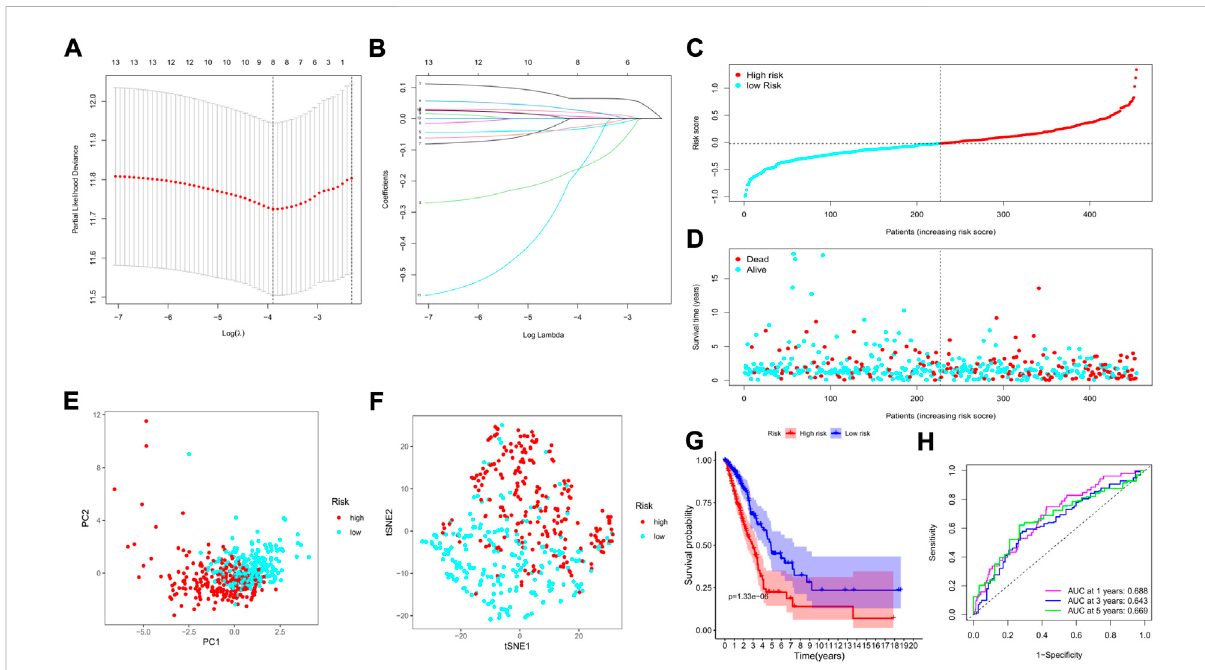
FIGURE 5 Construction of a risk model based on the TCGA cohort. (A) The cross-validation for tuning the parameter selection; (B) The LASSO regression forthe13candidategenes; (C) Thedistributionofriskscoresforthepatients; (D) Survivalstatusforeachpatient(low-risk:leftofthedottedline;high- risk:rightofthedottedline); (E) ThePCAplotbasedontheriskgroups; (F) Thet-SNEanalysisforthetworiskgroups; (G) TheKaplan – Meiercurvesto show the survival possibilities between low- and high-risk group; (H) The time-dependent ROC curves for 1-, 3-, and